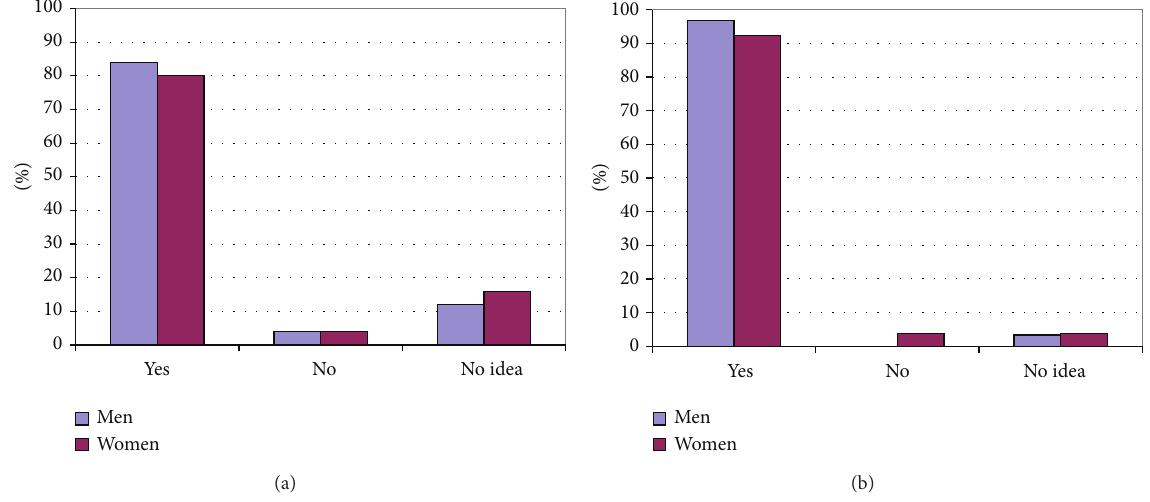
Figure 2: Technological equipment: GPS-availability within smartphones. DN (a) and DI (b).